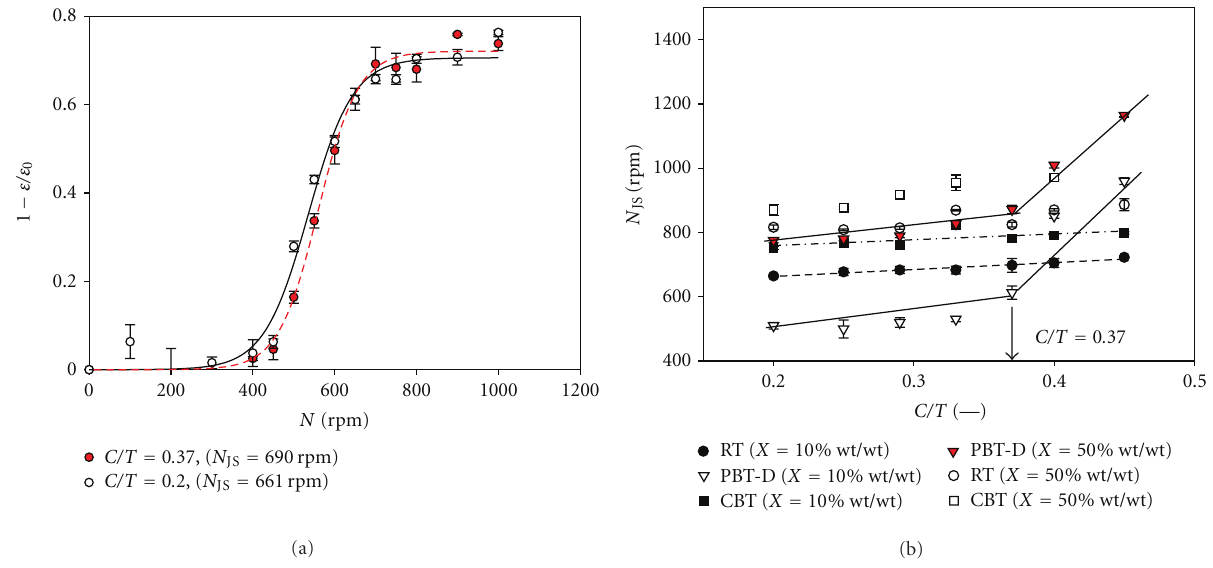
Figure 6: (a) Variation of solid hold-up at the vessel bottom for low and high impeller clearance, Impeller: RT. (b) Variation of N JS by impeller